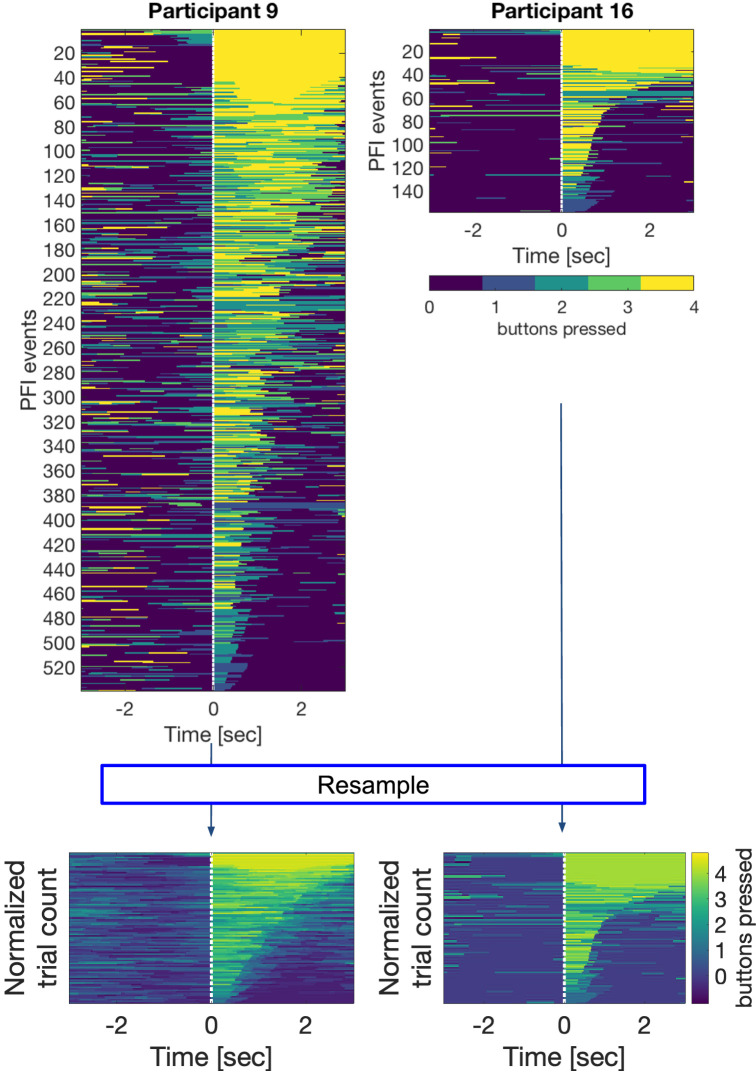
Preprocessing for event-by-event based image analyses.PFI events were first sorted according to the duration-weighted number of buttons pressed over 3 s, occurring after button press or before button release. Each image along the y-axis was then resampled to normalize the number of trials from 1 to 100 samples. The same process was also applied to RESS log(SNR) after sorting by the duration-weighted button press per trial based on button press (or release). This image-based analysis enables us to compare PFI dynamics despite differences in the frequency and duration of PFI events per participant.
Figure 2—figure supplement 3—source data 1.Example PFI events.